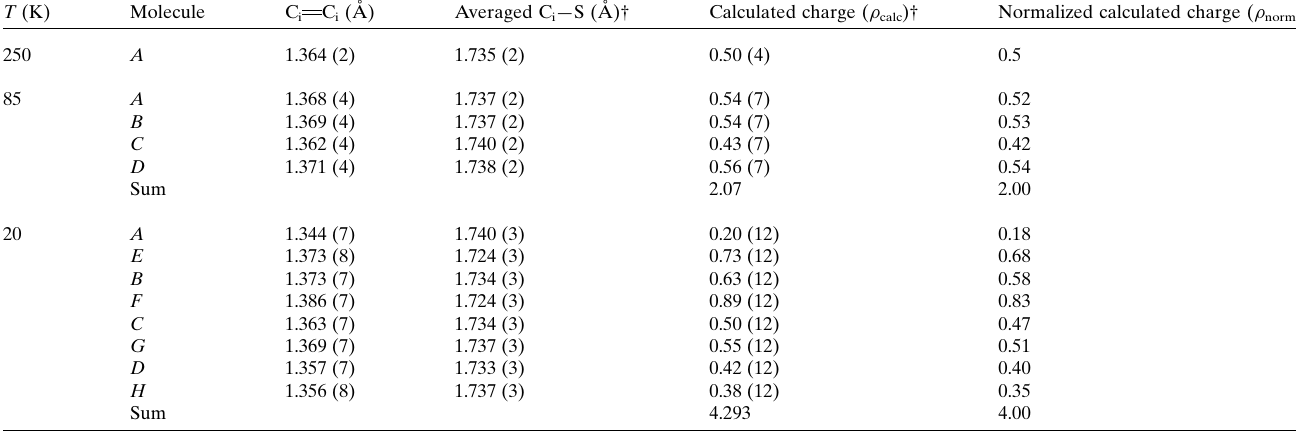
Table 3 Calculated charges of the o -Me 2 TTF molecules at the three different temperatures, based on the application of the formula (cid:8) = 21.823 (cid:7) [(C i C i )/ (C i —S)] (cid:2) 16.654.